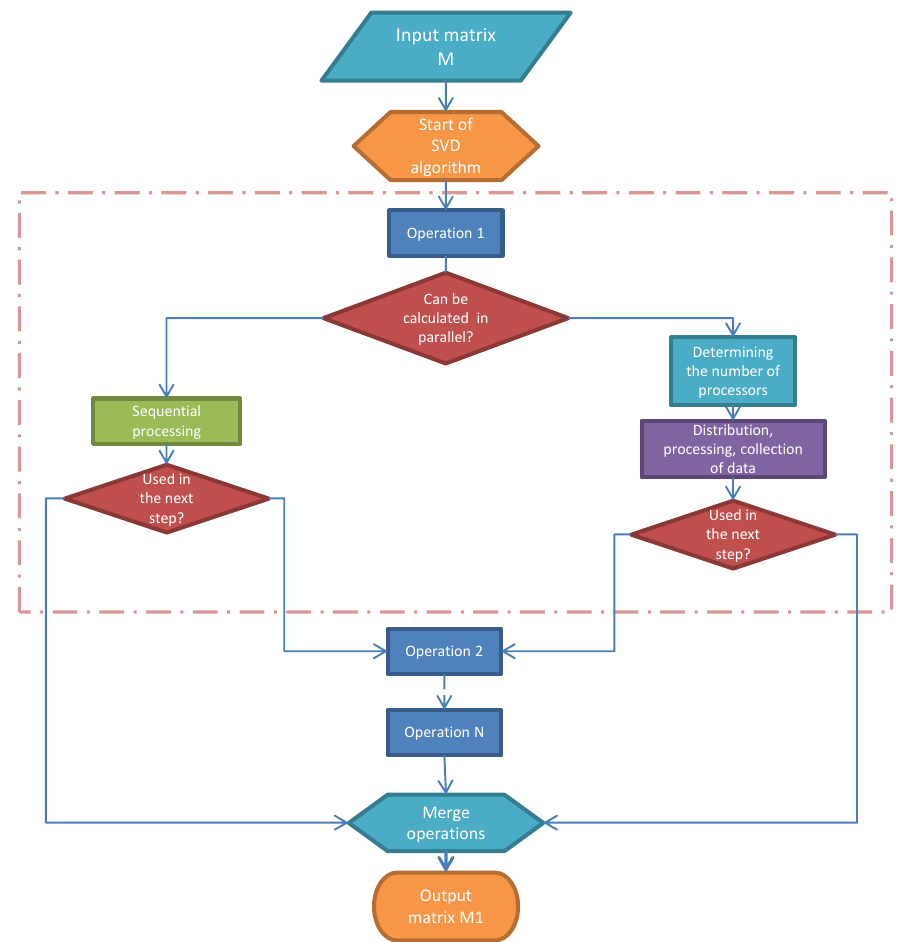
Figure 3. Algorithm for determining the maximum number of distributed operations in the SVD algorithm.